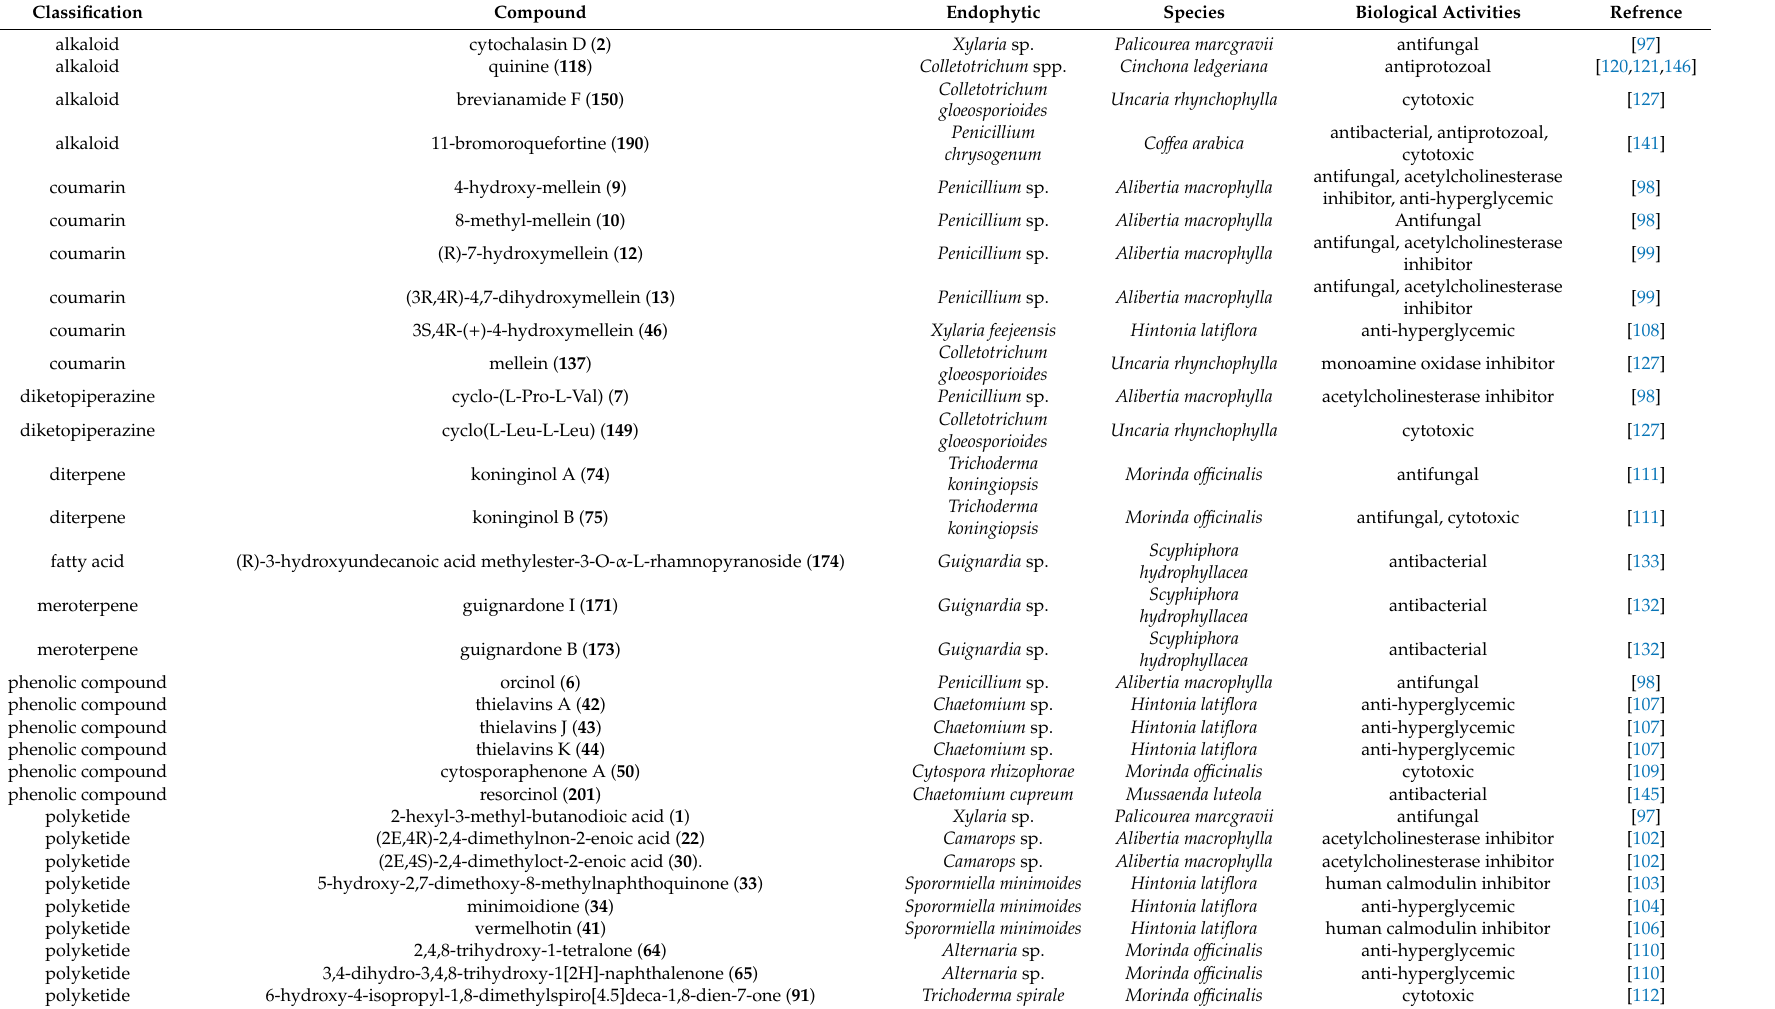
Table 1. Compounds produced by endophytic fungi associated with various genera of Rubiaceae and their respectively biological